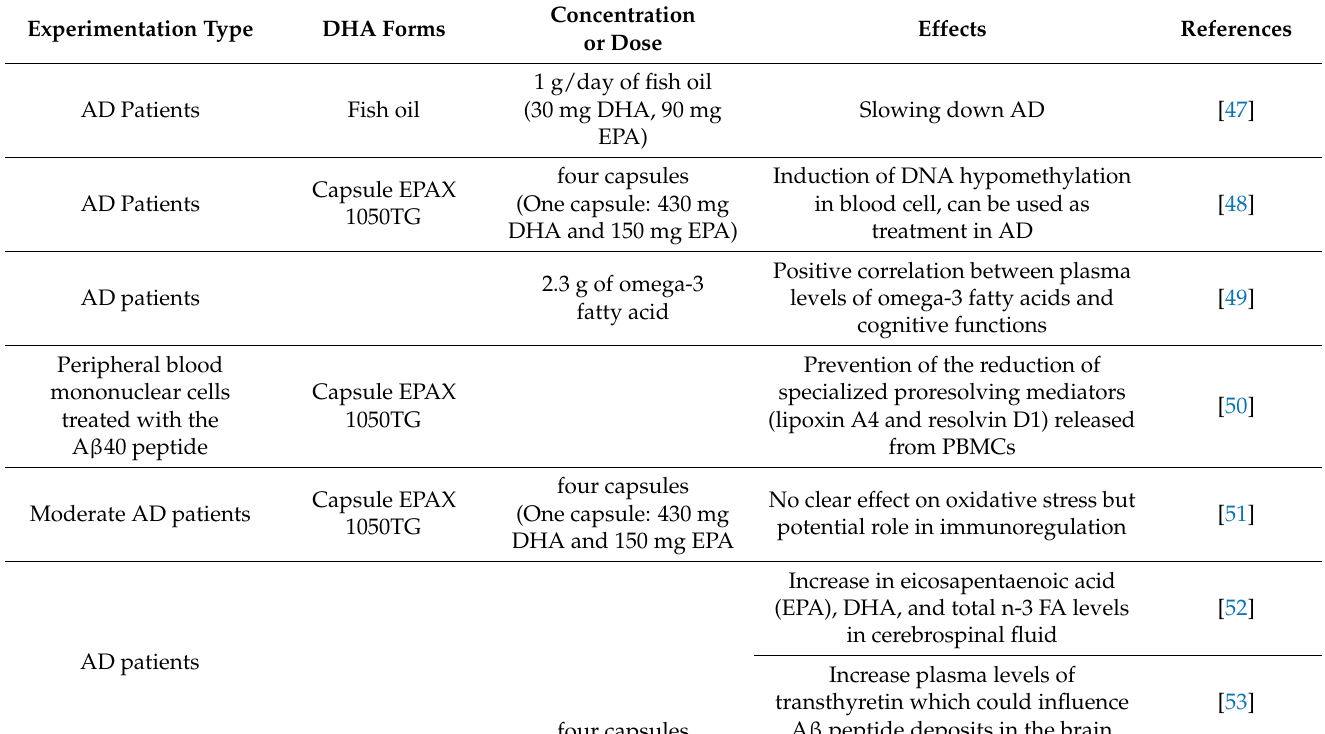
Table 3. Clinical trials involving